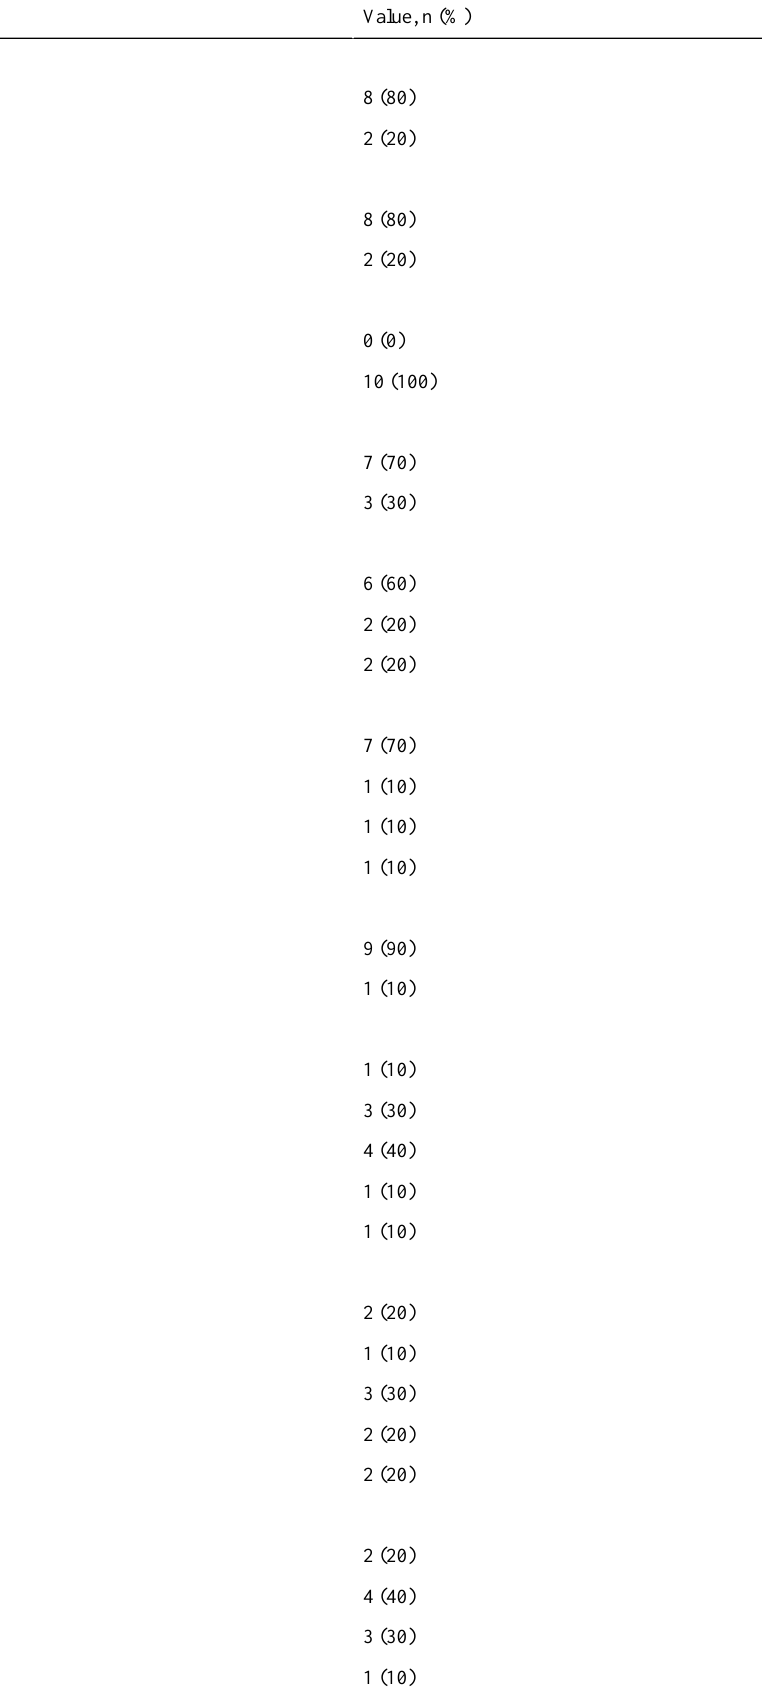
Table 1. Sociodemographic characteristics of patients